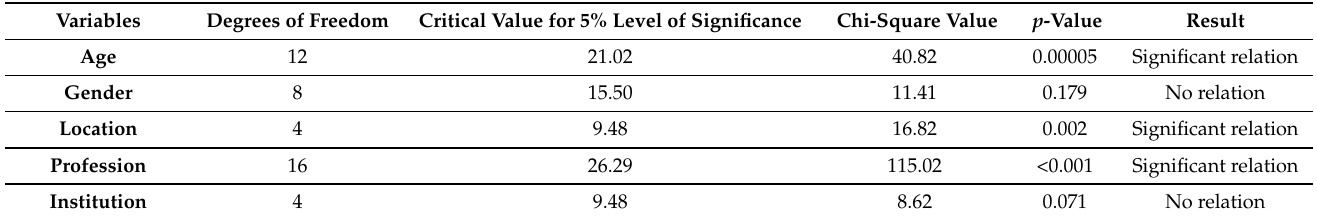
Table 3. The influence of different variables on psychological